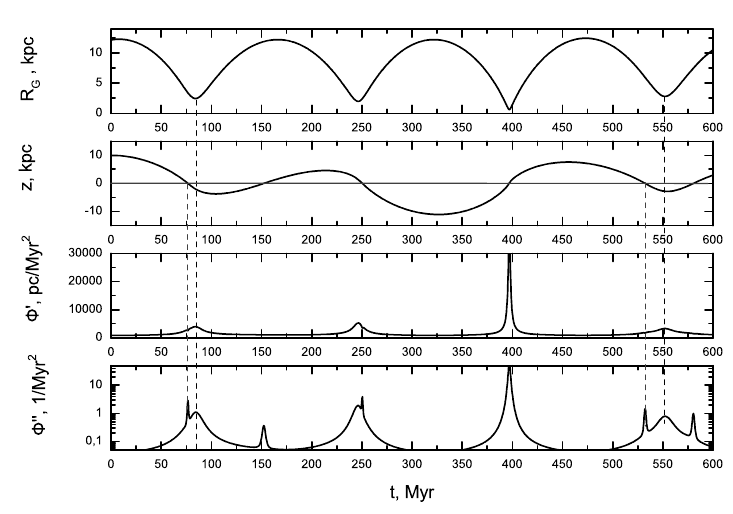
Fig. 4. Time variations of the galactic acceleration and tidal force along the GC